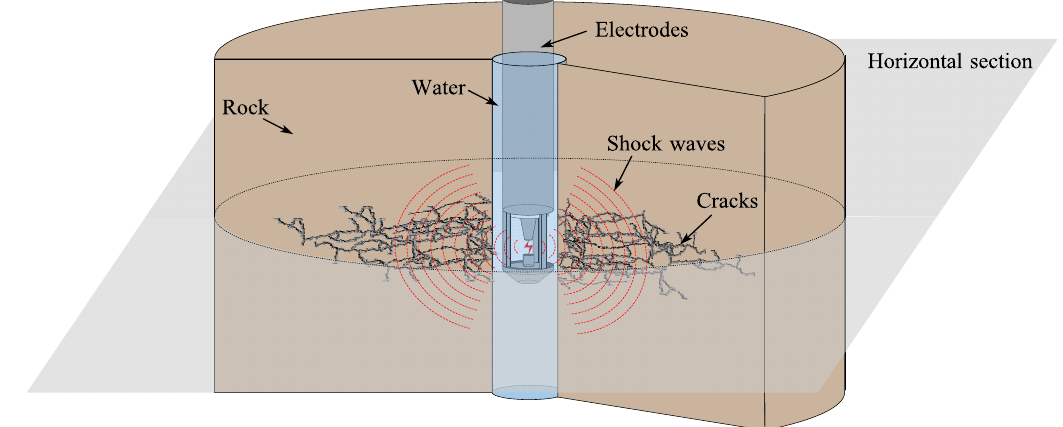
Figure 2. Schematic diagram of three-dimensional electrohydraulic shock wave fracturing.